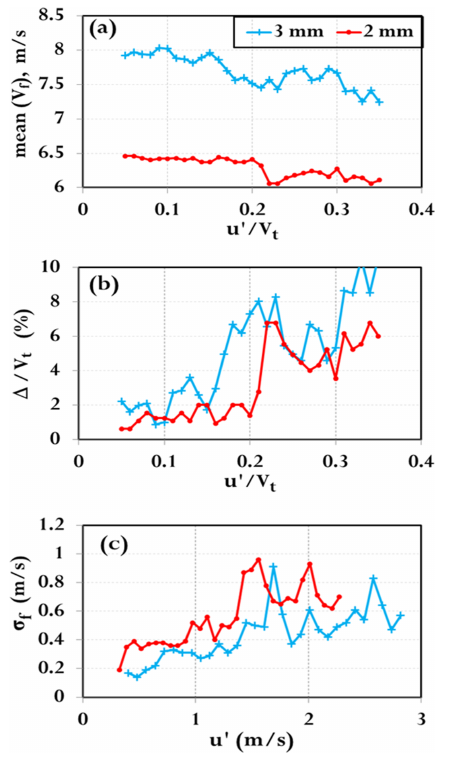
Figure 7. (a) The mean fall speed ( < V f > ) versus turbulent in- tensity for the 2 and 3mm drops, (b) the deviation of the mean fall speed from the terminal velocity ( (cid:49) = V t − < V f > ) normalized by V t and, (c) the standard deviation ( σ f ) versus u (cid:48) .